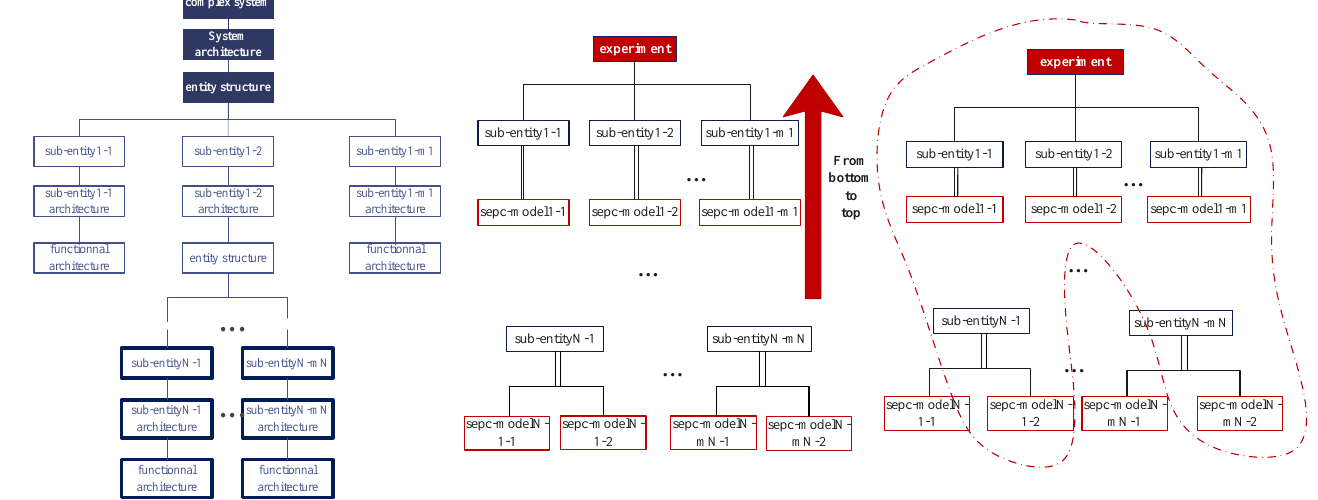
Figure 7. Physical model and pruned physical model of